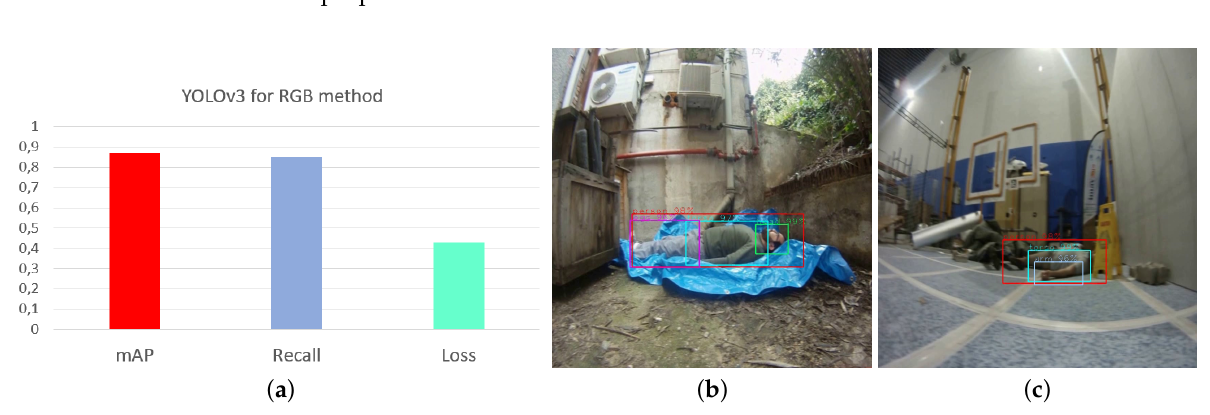
Figure 14. Evaluation of the conventional method that uses RGB images for the detection of victims with good lighting conditions, using CNN-YOLOv3. ( a ) Neural Network Training. ( b ) Outdoor evaluation. ( c ) Indoor evaluation. Source: Authors.